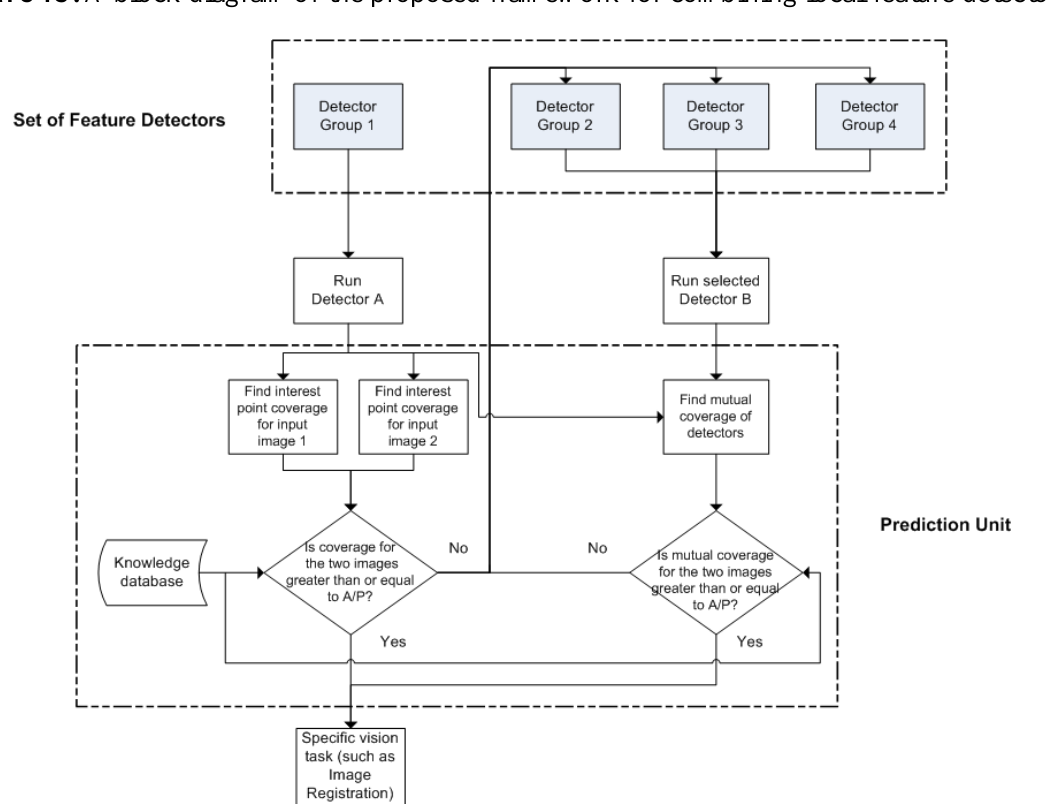
Figure 13. A block diagram of the proposed framework for combining local feature